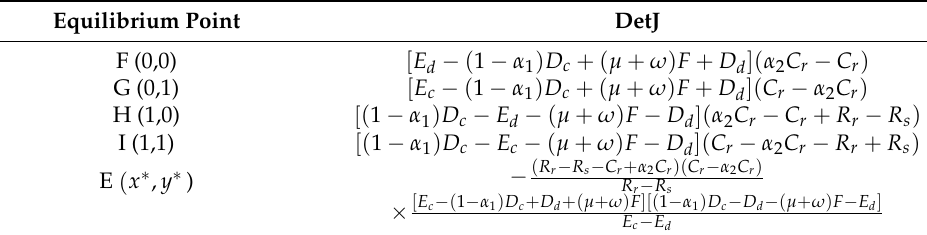
Table 6. Determinant at the equilibrium point of the system.